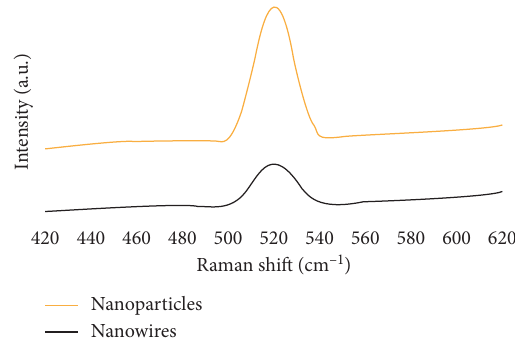
Figure 1: Raman spectrum of synthesized SiO